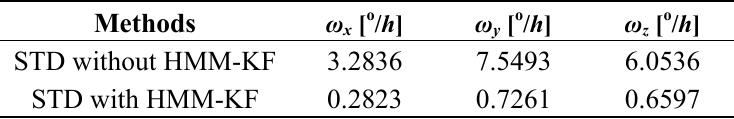
Table 3. STD of gyroscope outputs with and without HMM-KF.